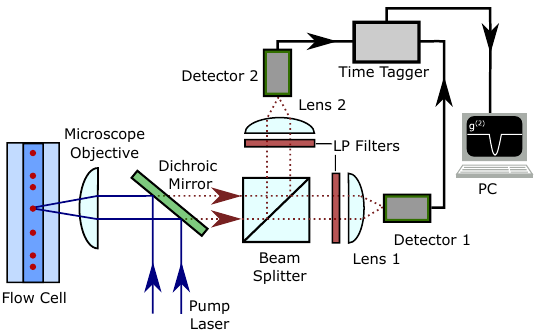
Figure 2. Proposed experimental setup for autocorrelation measurement on the fluorescence signal emitted by the biomarkers in a flow